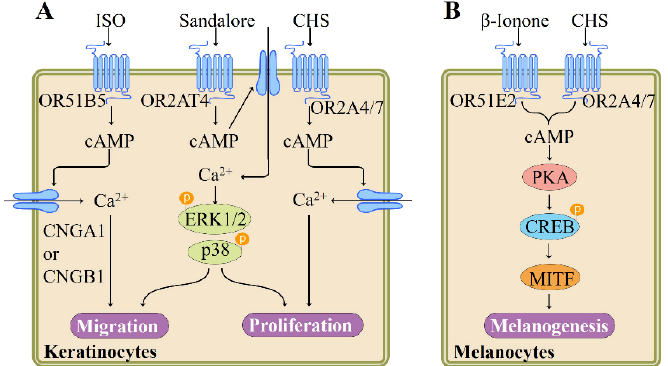
Figure 4. Summary of signaling pathways and functions regulated by ectopic ORs in skin cells, adapted from [74], published by Elsevier, 2018. ( A ) Activation of OR51B5, OR2AT4, or OR2A4/7 increases the migration and proliferation of keratinocytes, adapted from [75,76], published by NATURE PUBLISHING CO., 2019 and Wiley, 2017. ( B ) Both OR51E2 and OR2A4/7 activation enhances melanogenesis, adapted from [77,78], published by Nature, 2018 and American Society for Biochemistry and Molecular Biology, 2016. cAMP, cyclic adenosine monophosphate; CREB, cAMP-responsive element-binding protein; CNGB1, cyclic nucleotide gated channel subunit beta 1; CNGA1, cyclic nucleotide gated channel subunit alpha 1; ERK1/2, extracellular signal-regulated kinase-1/2; MITF, microphthalmia-associated transcription factor; PKA, protein kinase A; p38, p38 mitogen–activated protein